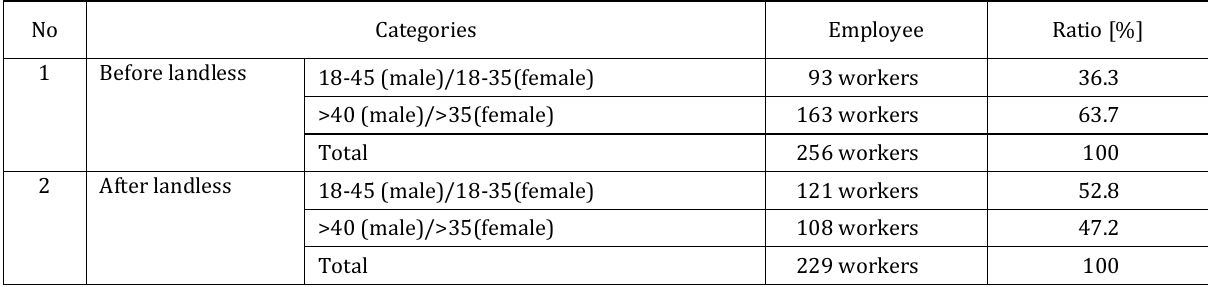
Table 2. Proportion of employed workers by age group (Source: Households' survey, 2020)